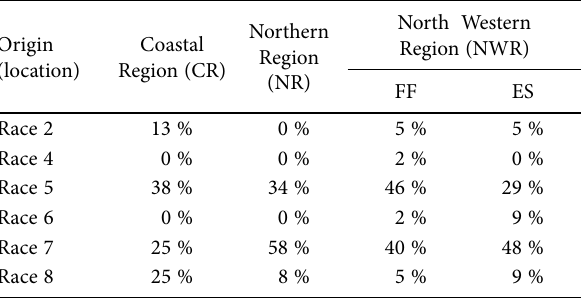
Table 1. The Pyrenophora tritici-repentis race structure and distribu- tion in Tunisia.